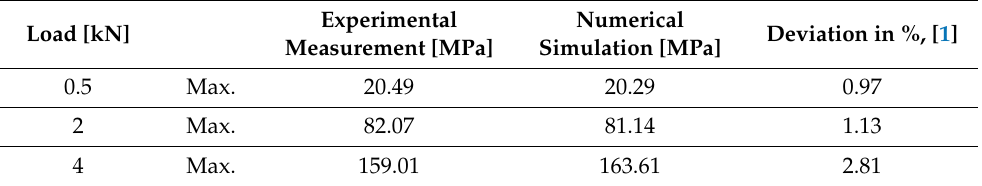
Table 2. Comparison of the deviation of the results of numerical simulation and experimental